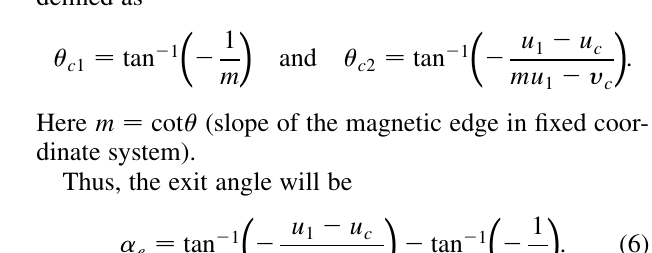
FIG. 1. Geometry of design trajectory and a deviated particle trajectory in the median plane of a sector dipole magnet with fixed coordinate